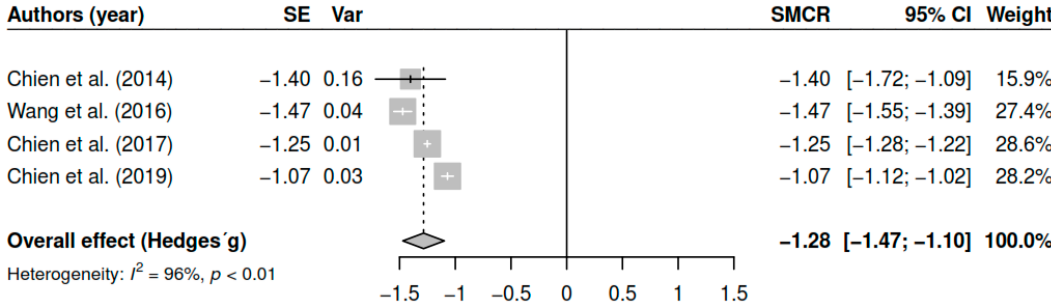
Figure 7. Forest plot for the model of random-effects and the values of Hedges’ g statistics in the functioning variable (pretest–posttest).